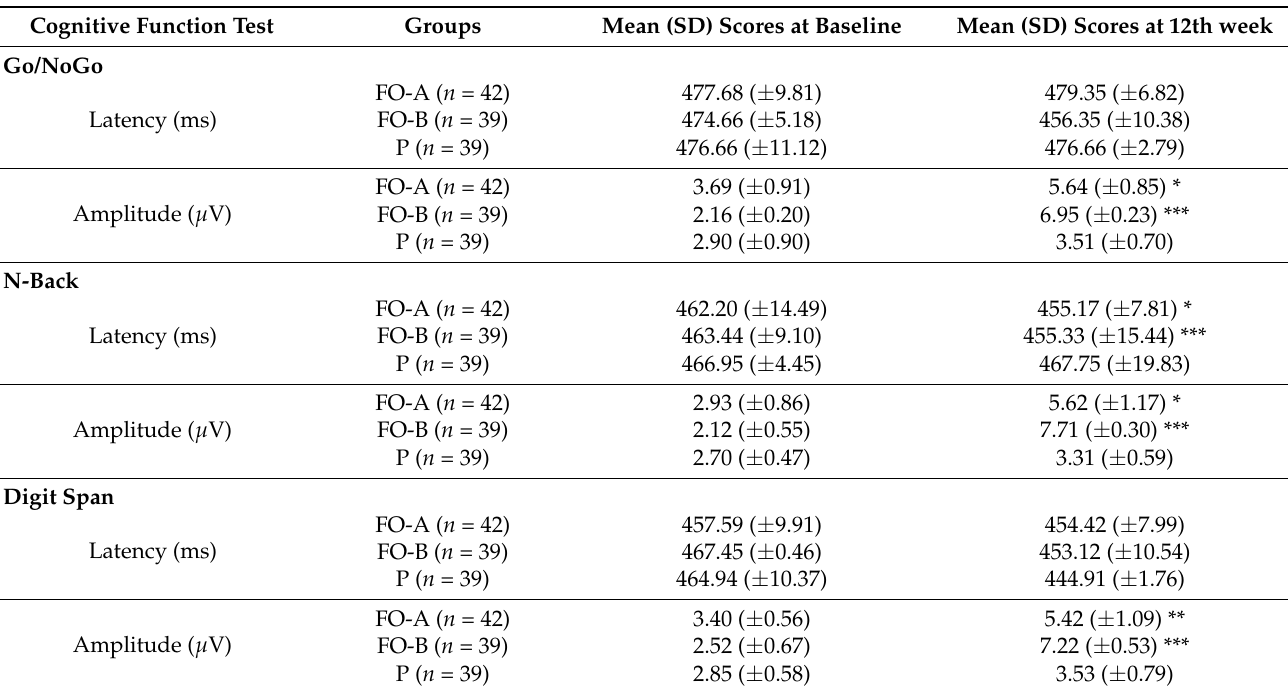
Table 4. The effect of fish oil (FO) on the grand mean global field power (GFP) of event-related potentials (ERPs)